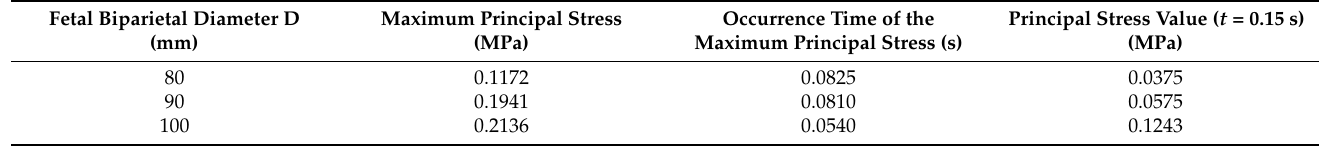
Table 4. Principal stress data